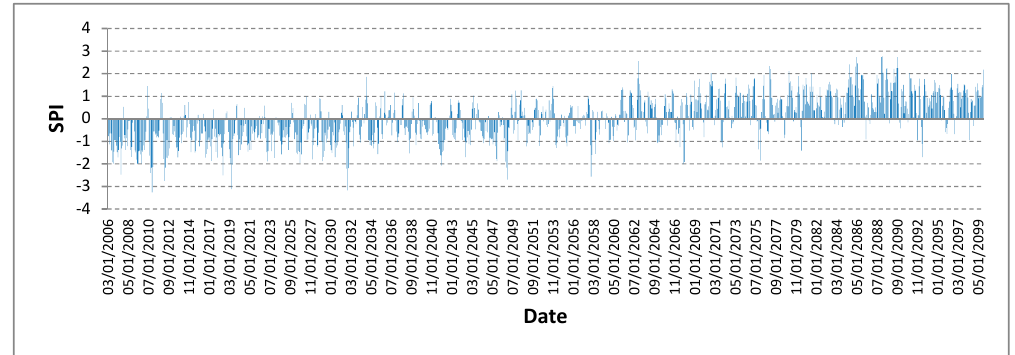
Figure 15. CanESM2 3-month period SPI values for Agoro for the duration 2006–2099.